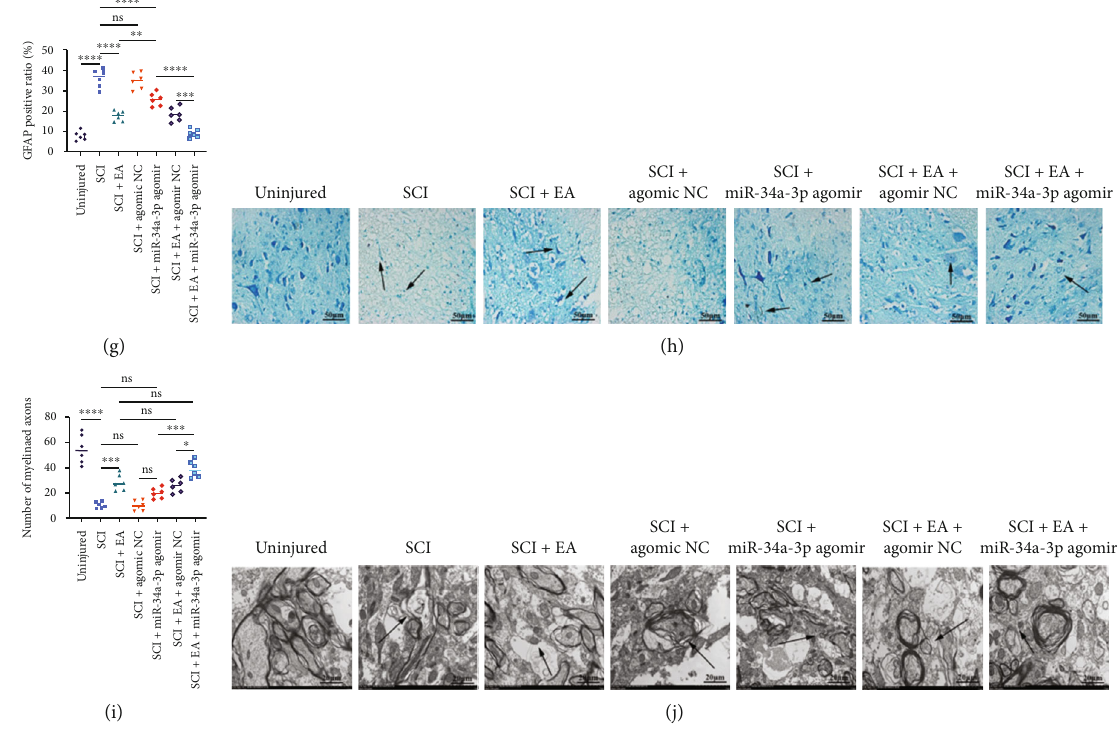
Figure 6: EA upregulates miR-34a-3p to promote post-SCI axonal myelination. (a – d) Western blotting analysis and quanti fi cation of GFAP, NF-200, and MBP protein levels under EA stimulation and miR-34a-3p agomir treatment following SCI. Six experiments were performed in triplicate from six animals ( n = 6 animals/group)), and the representative images are shown. The gray value of bands from each band relative to β -actin is presented in the graphs. (e – g) Immuno fl uorescence assay of NF200 and GFAP and quantitative analysis of NF200- and GFAP-positive ratios under EA stimulation and miR-34a-3p agomir treatment following SCI. Representative images of stained tissues sections from six di ff erent animals per group are shown. The quantitative analysis showed the positive ratio of each protein; scale bars = 50 μ m . (h) Toluidine blue staining showing that the number of myelinated axons was signi fi cantly elevated in response to either EA stimulation or treatment with miR-34a-3p agomir following SCI, scalebars = 50 μ m . Representative images of stained tissues sections from six di ff erent animals per group ( n = 6 animals/group) are shown. (i) Quanti fi cation of the myelinated axons; values from each of the six animals in each group are presented. (j) Viable myelinated axons in the spinal cord under the scanning electron microscope, scale bar = 20 μ m . Representative images of stained tissues sections from six di ff erent animals per group are shown. One-way ANOVA followed by the Tukey ’ s multiple comparisons test was utilized to identify di ff erences. The arrows indicated the injury parts; ∗ p < 0 : 05 , ∗∗ p < 0 : 01 , ∗∗∗ p < 0 : 001 , ∗∗∗∗ p < 0 : 0001 , and ns: nonsigni fi cant among the compared